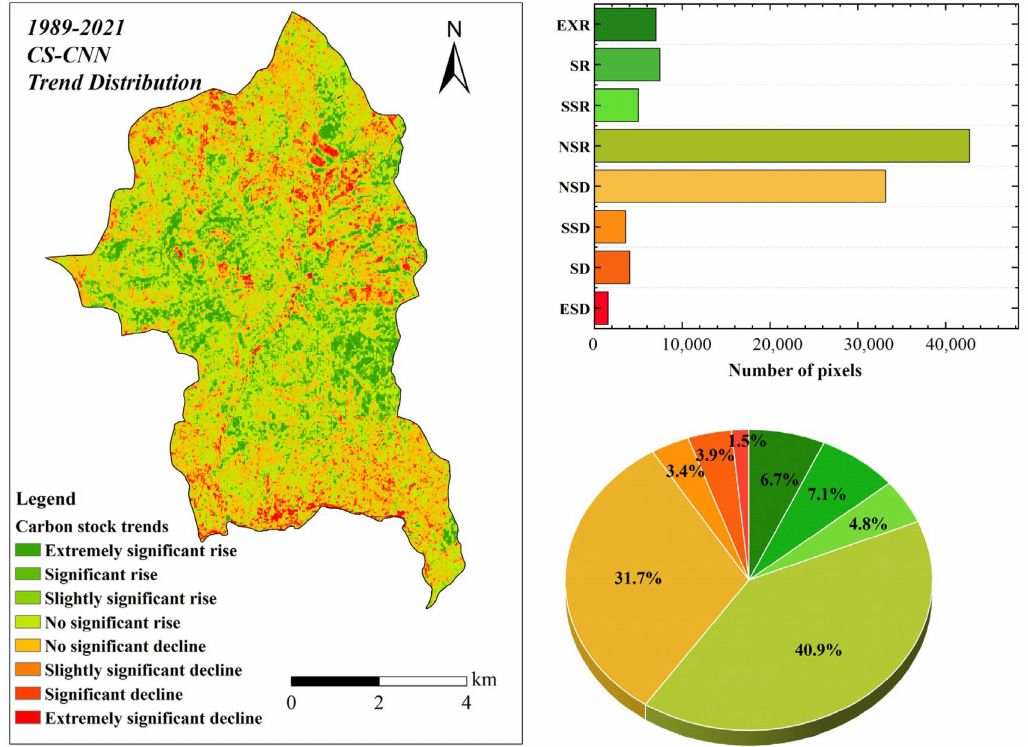
Figure 9. CS spatial variation trend map and the percentages of different